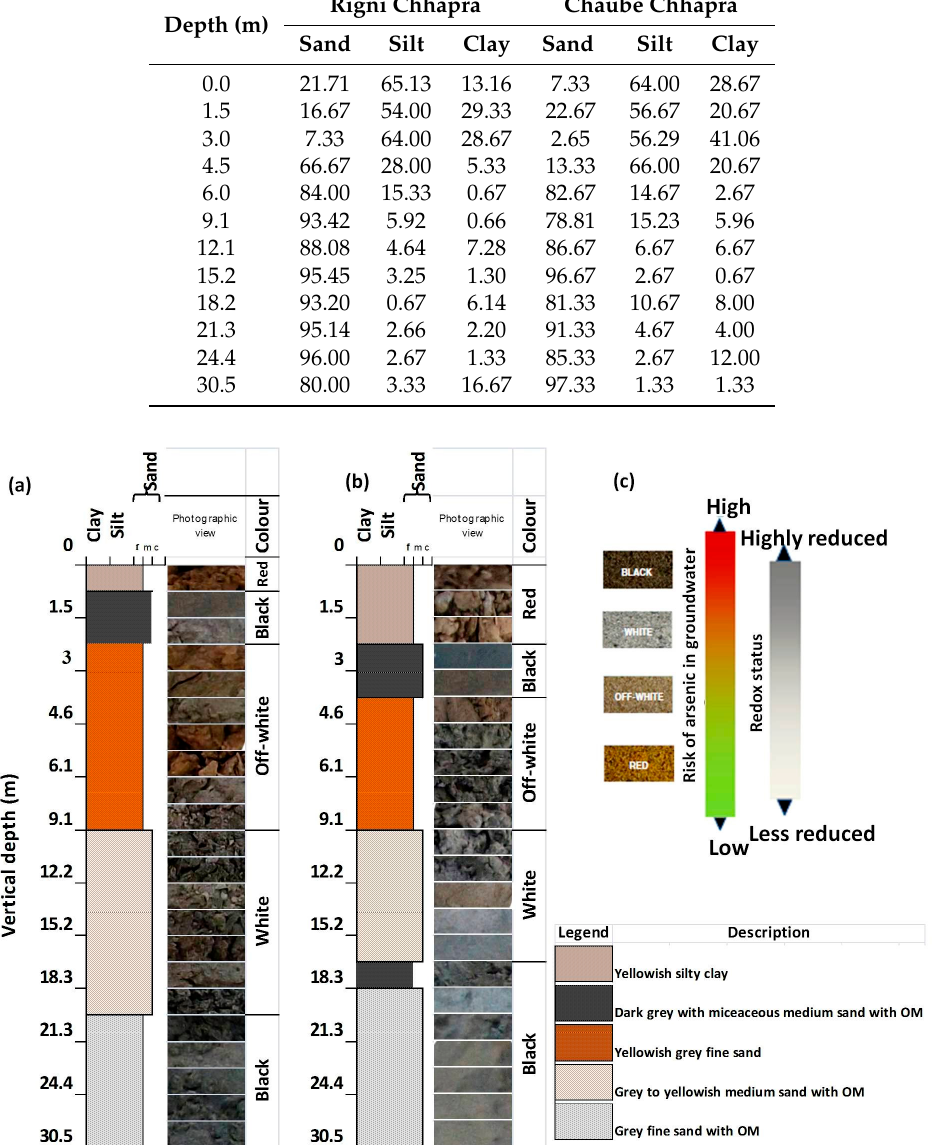
Table 1. Grain size distribution (in %) in the core sediments of Rigni Chhapra and Chaube Chhapra vertical below ground level. Rigni Chhapra Chaube Chhapra Depth (m)